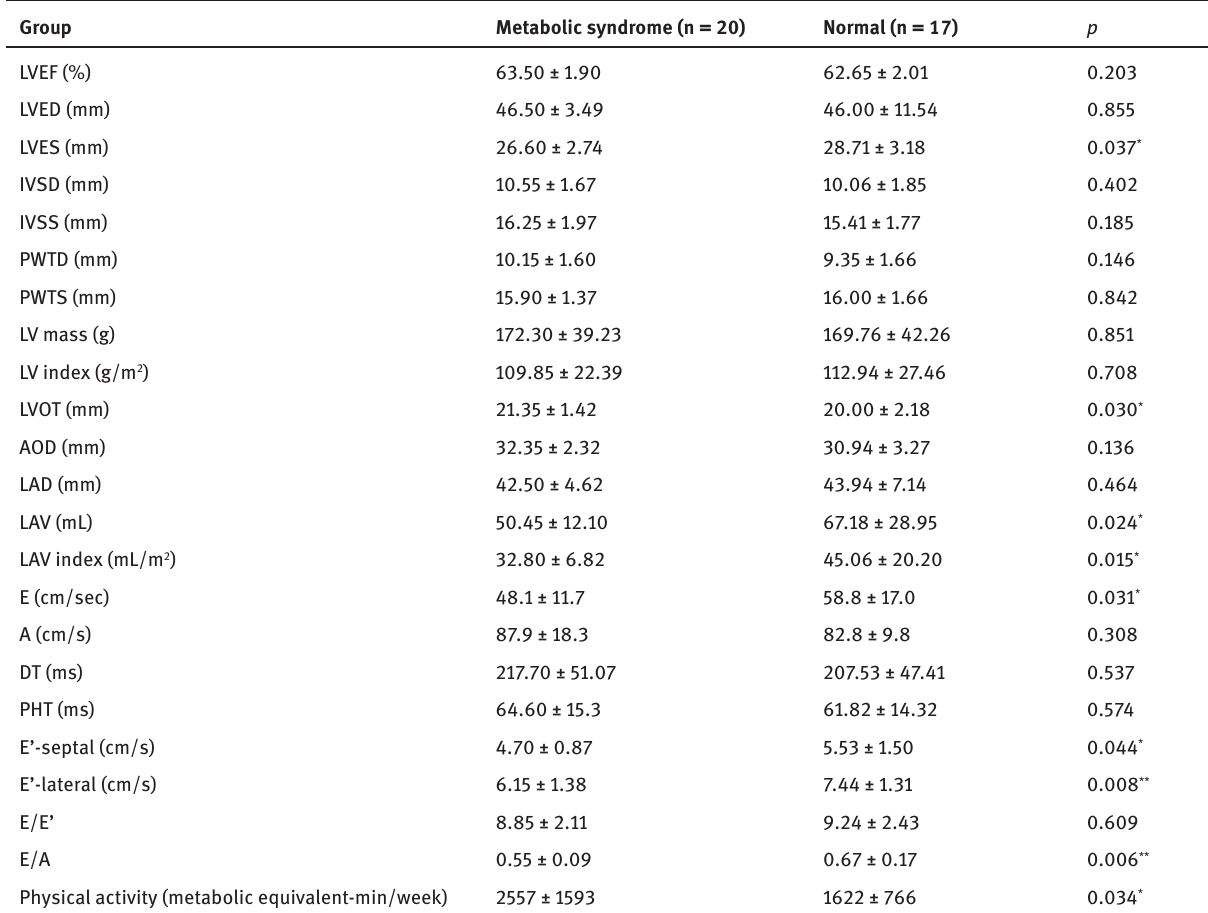
Table 2: Patient left ventricular function indices and physical activity levels